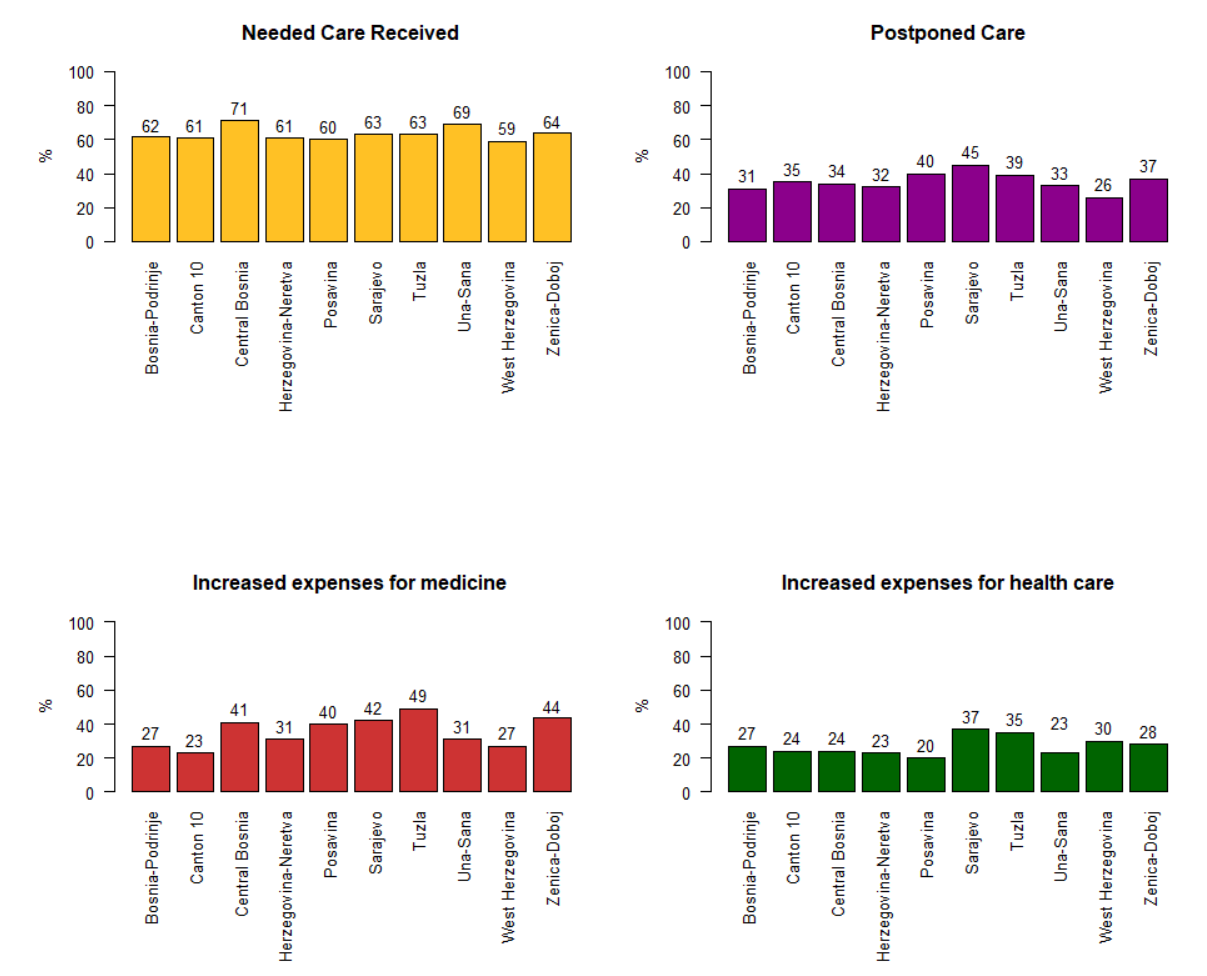
Figure 1. Some aspects of self-perceived access to care and postponements of care in the adult population of Bosnia and Herzegovina during the COVID-19 pandemic by